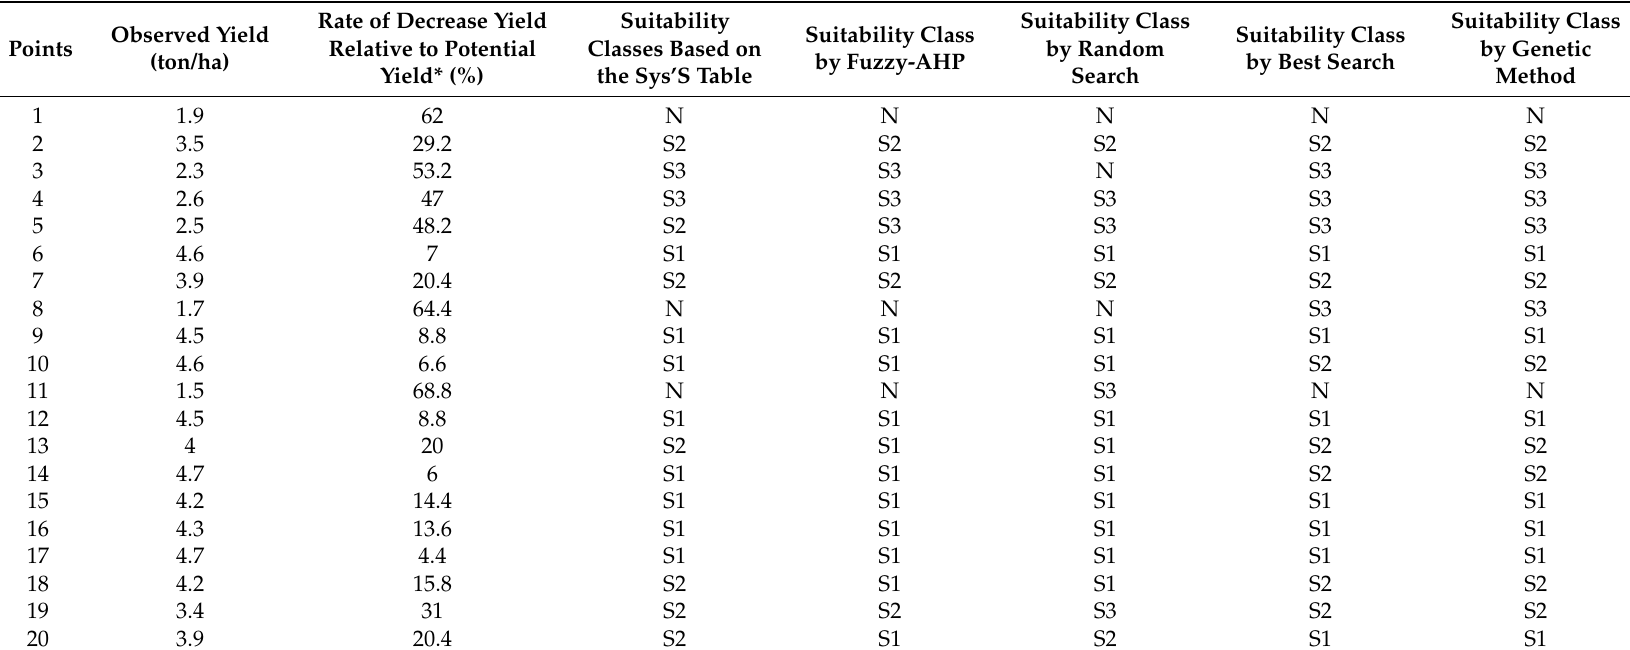
Table 8. Comparison of the results of different random search methods and standard FAO and fuzzy-AHP methods based on crop